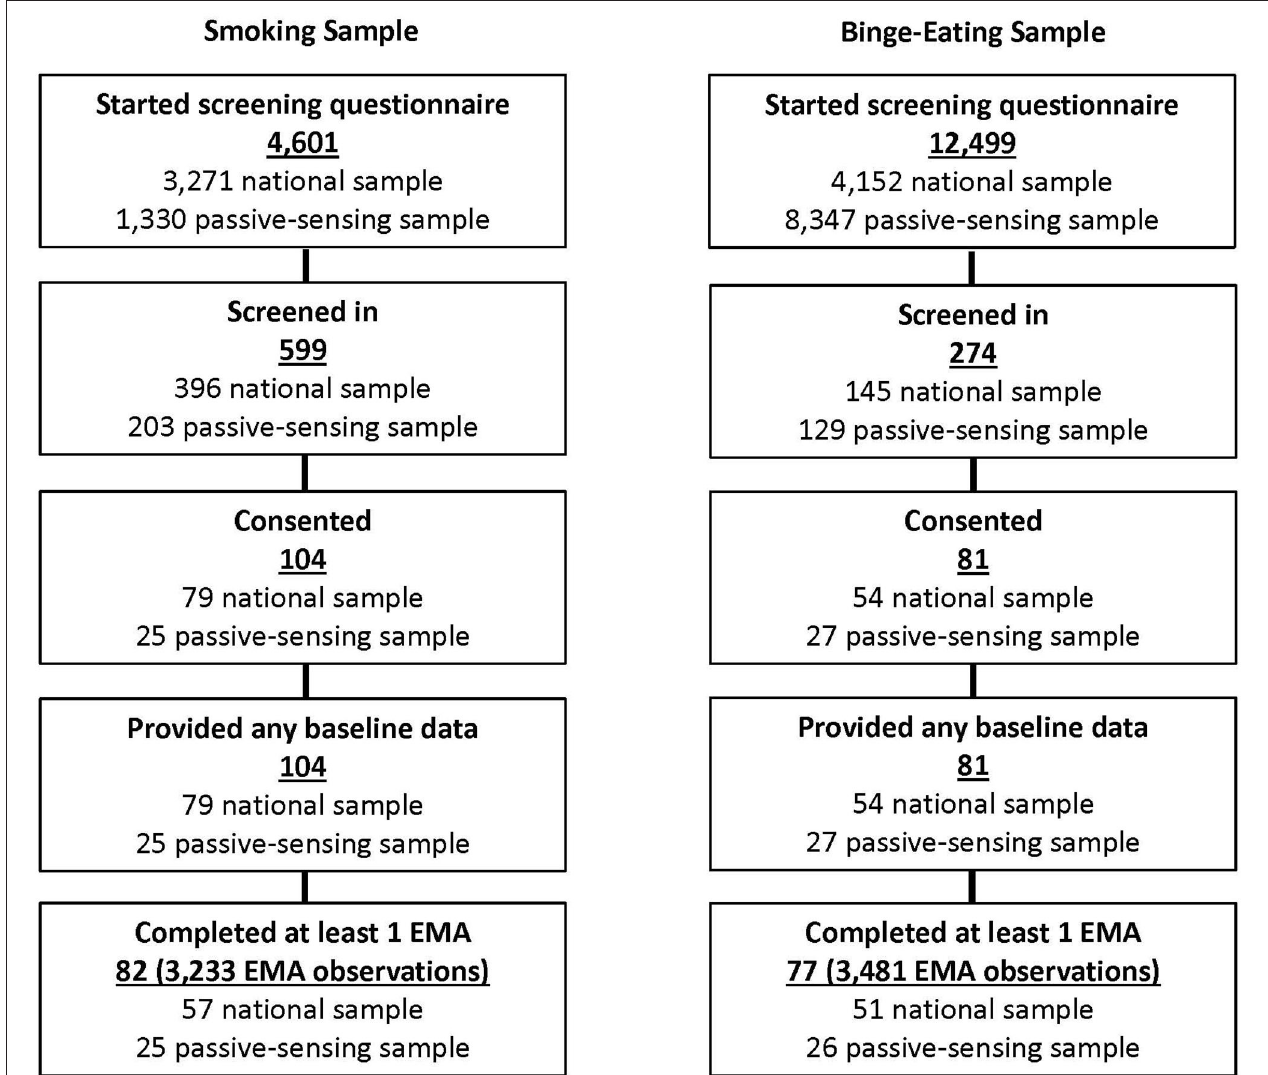
FIGURE 1 | Participant flow